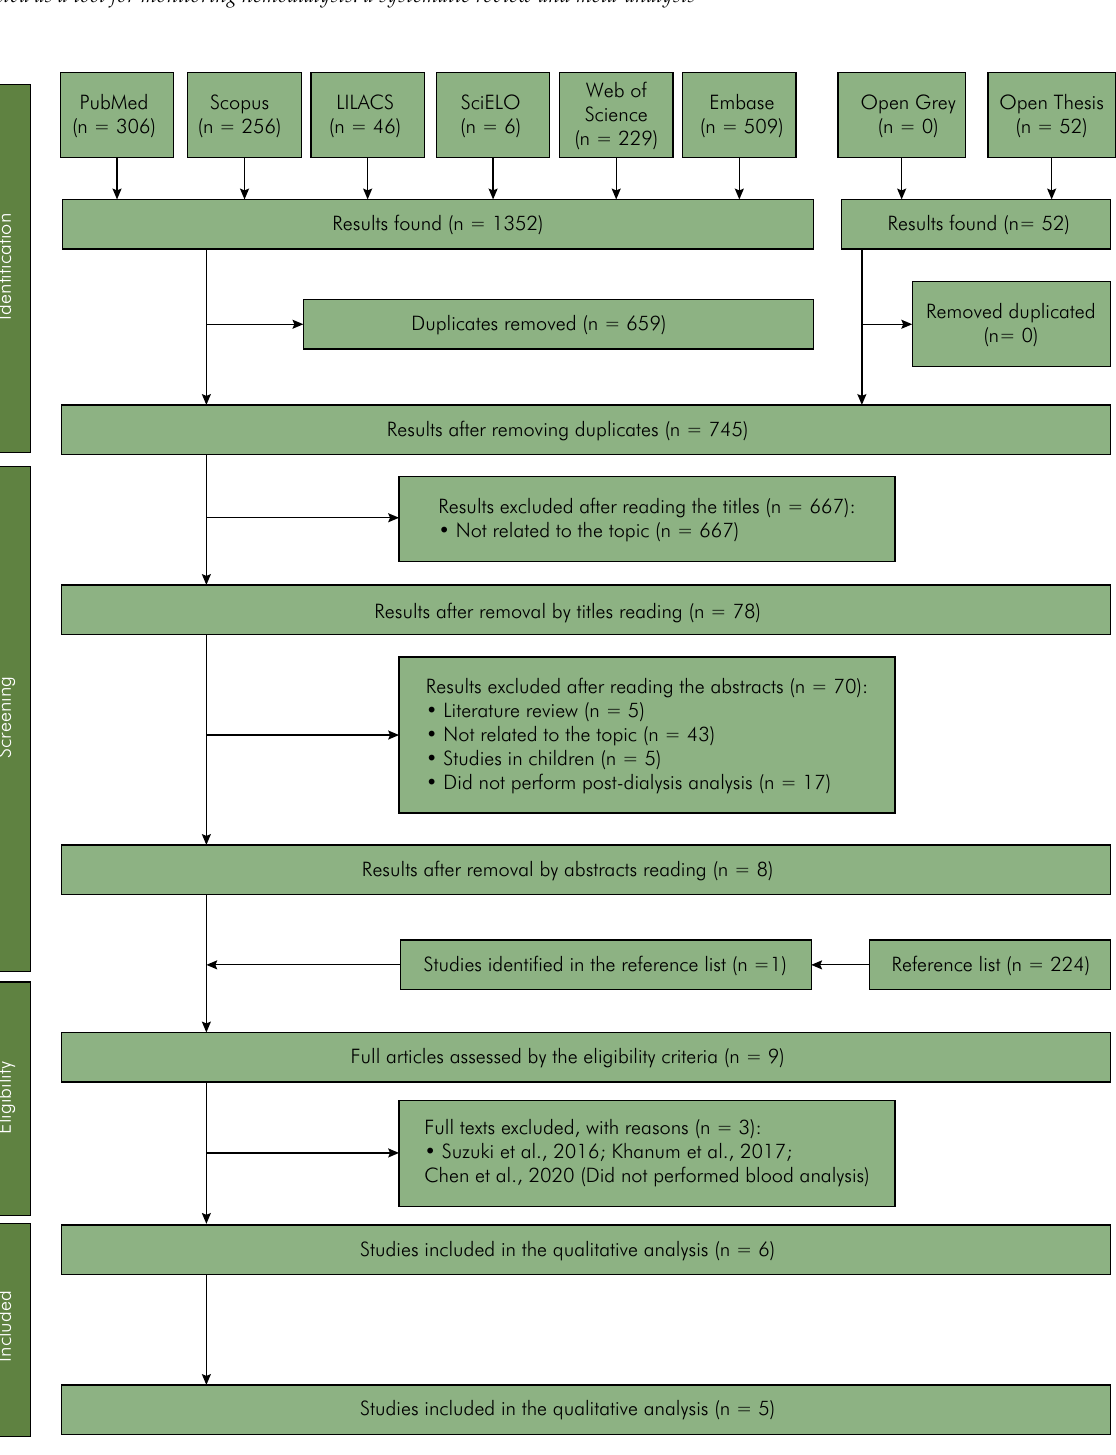
Figure 1. Flowchart of the literature search and selection process adapted from the PRISMA